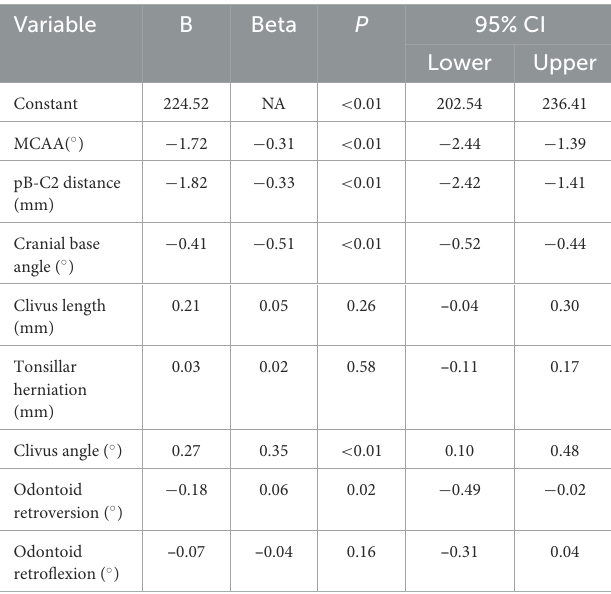
TABLE 2 Correlation of ONSD with other parameters by multiple linear regression model, p < 0.05 is statistically significance.